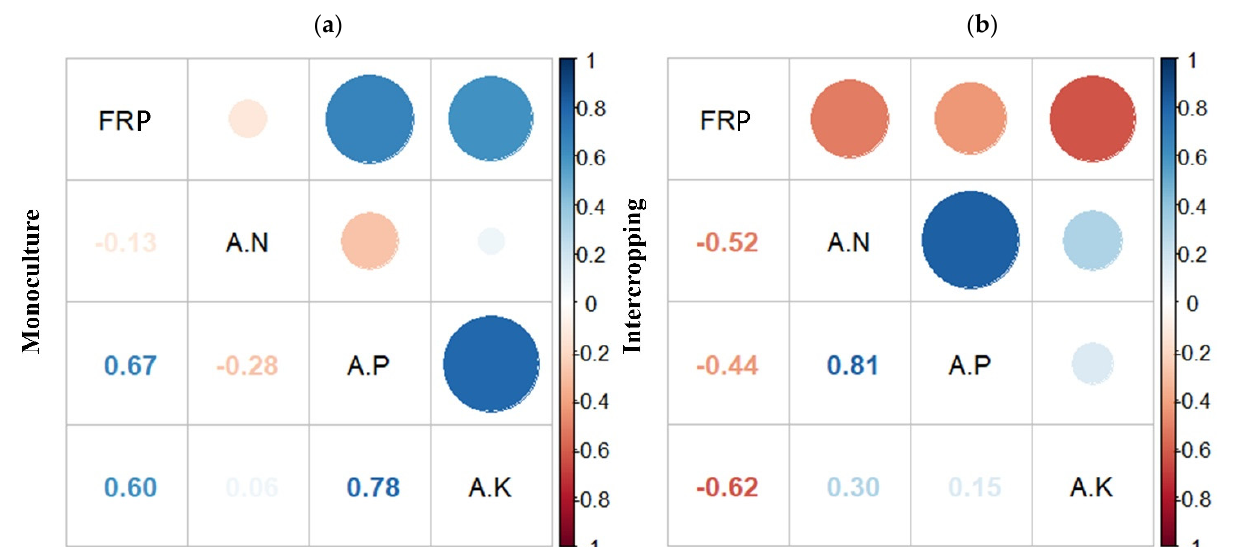
Figure 5. Pearson correlation matrices of fine root production (FRP), soil available nitrogen (A.N), soil available phosphorus (A.P) and soil available potassium (A.K) under two management systems: (a) rubber monoculture and (b) rubber– Flemingia intercropping. The significance levels for correlations are p < 0.001, p < 0.01 and p < 0.05. All variables were normalized prior to correlation testing.